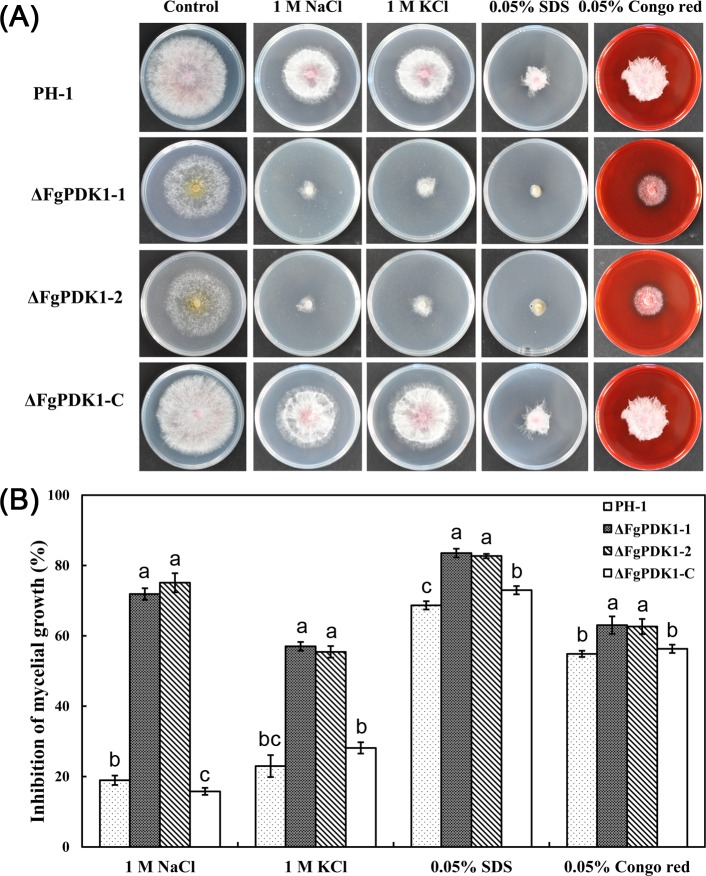
Stress response of the wild-type strain PH-1, the FgPDK1 deletion mutant (ΔFgPDK1), and the complemented strain (ΔFgPDK1-C).The strains were grown in medium containing different chemicals as indicated. Then the photographs were taken (A), and the inhibition of mycelial growth were measured (B). The mean values of three replicates followed by different letters indicated significance of difference between the treatments (P<0.05, ANOVA, LSD).